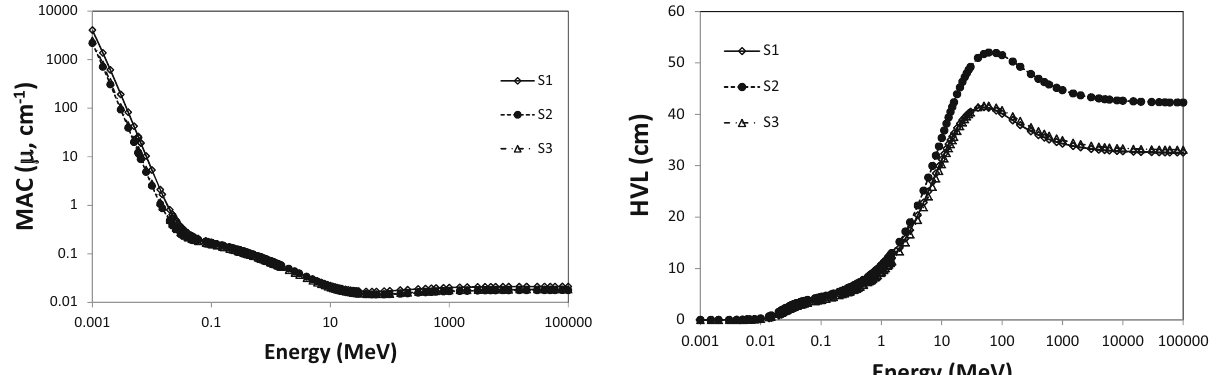
Figure 4: The MAC distribution as a function of gamma - ray energies.